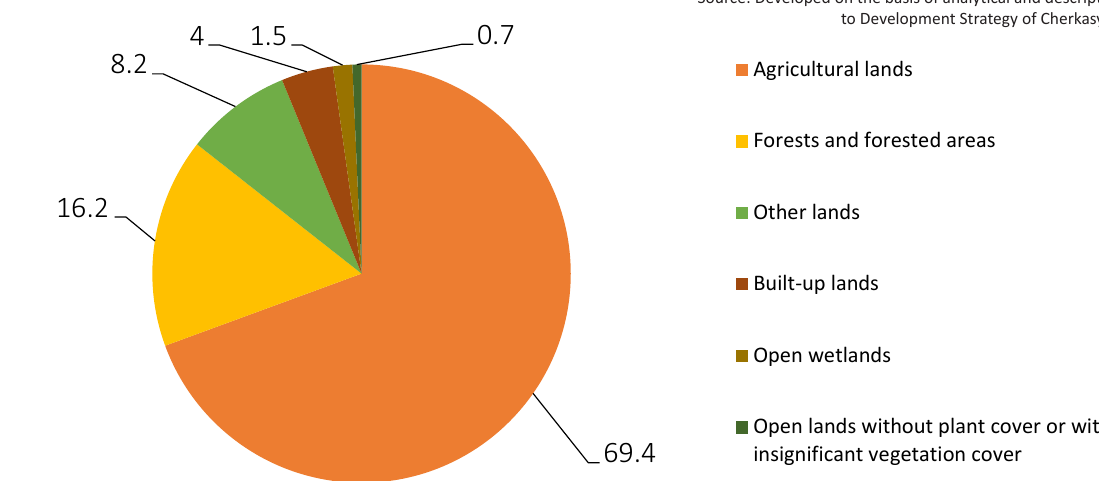
Source: Developed on the basis of analytical and descriptive data to Development Strategy of Cherkasy region.